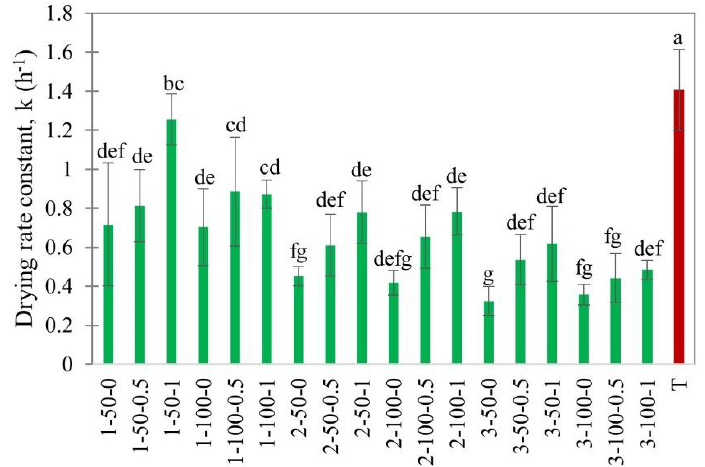
Figure 6. Drying rate constant of EHD (marked in green and labeled as thickness-slice load density- airflow) and hot air-dried (marked in red as T) apple slices. Different lower-case letters indicate statistically significant differences ( p < 0.05).